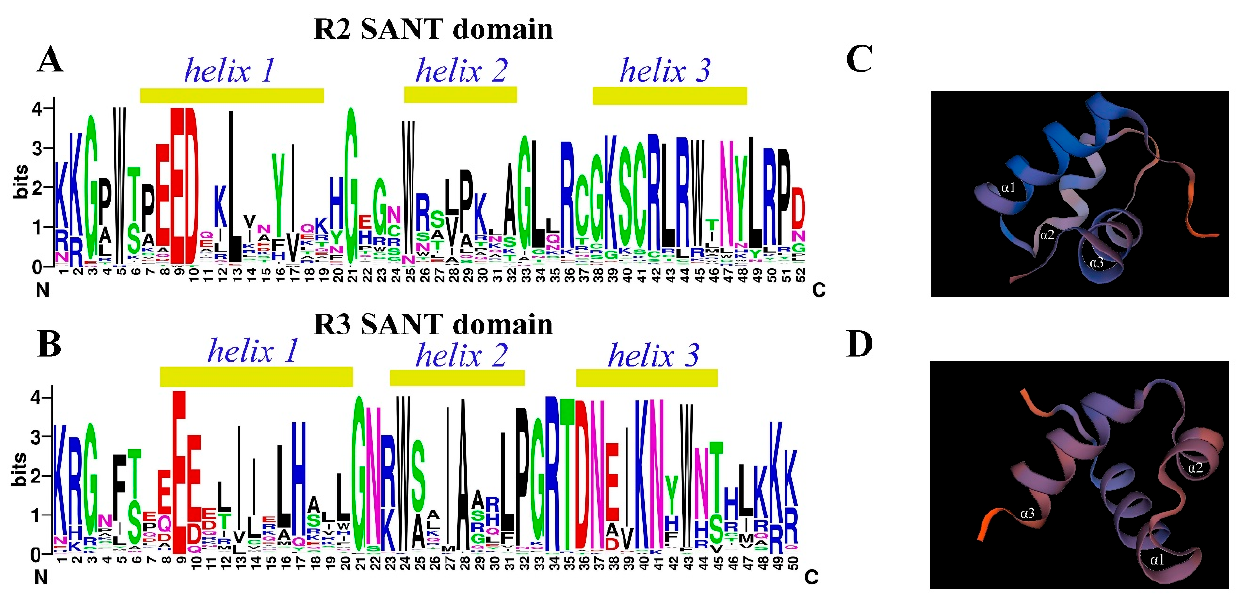
Figure 3. Domains of HbR2R3-MYBs and 3D structure models of R2 and R3 MYB repeats. Sequence logos of R2 domain ( A ) and R3 domain ( B ). The bit score indicates the information content for each position in the sequence and the light yellow box above the sequence indicate the HTH structure. Predicted 3D structure models of the R2 ( C ) and R3 domains ( D ). The 3D structure of the R2 and R3 repeats domains was constructed using AtMYB66 (PDB: 6kks) as a